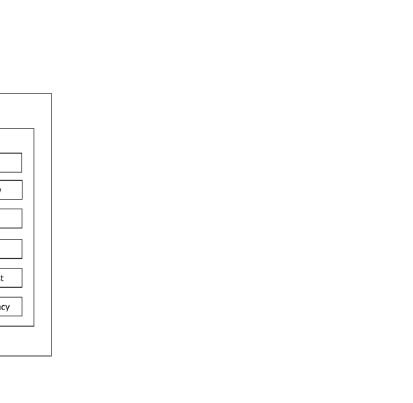
Figure 1. Flowchart for the overall process of machine learning MEG synchrony discovery framework.